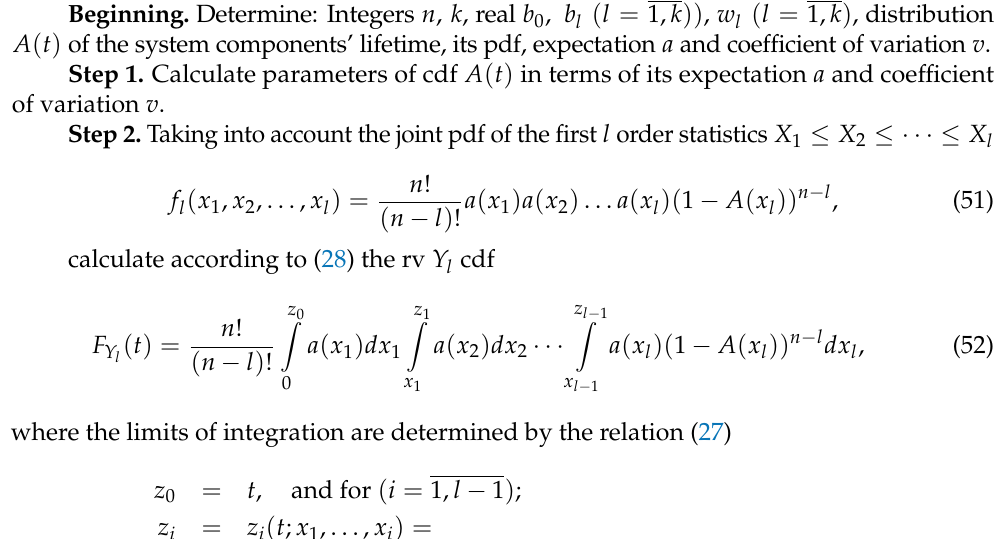
Algorithm 1 General algorithm for calculation of the reliability